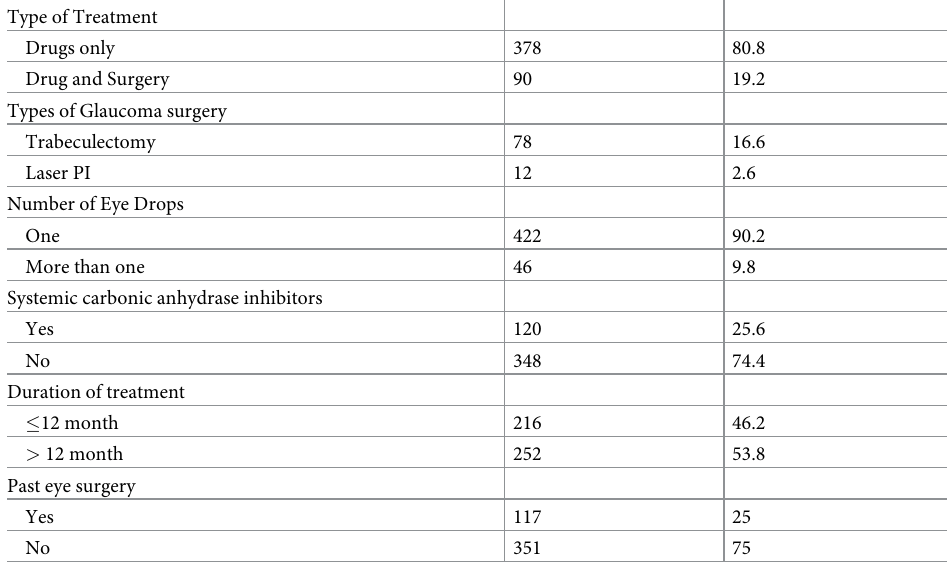
Table 4. Type and duration of glaucoma treatment among study